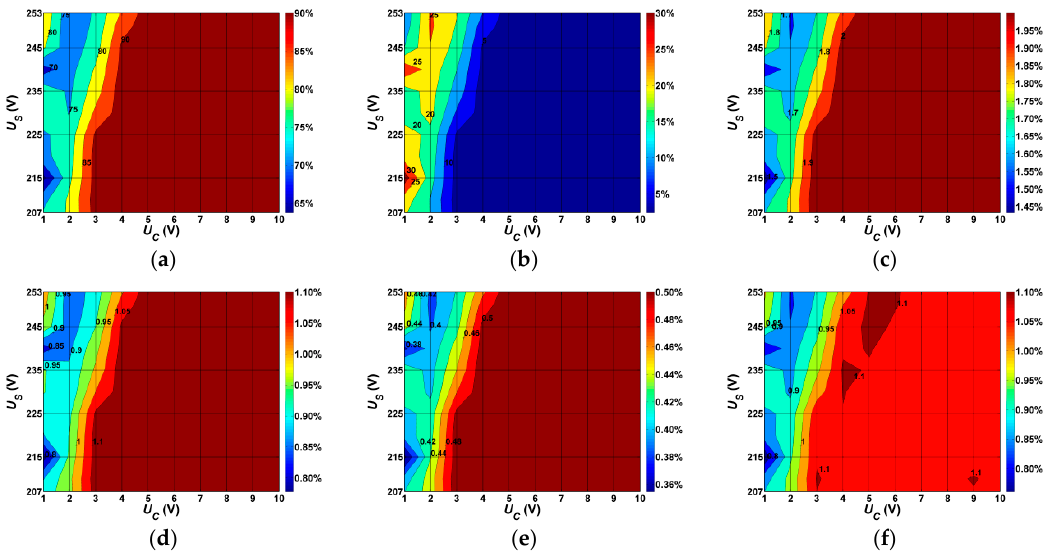
Figure 3. Power losses in elements of the lighting system as percentages of total power losses Δ P TOTAL : ( a ) losses in the supply cable; ( b ) losses in the neutral conductor of the supply cable; ( c ) losses in the wire in the pole between the fuse box and the luminaire; ( d ) losses in the safety device in the distribution board; ( e ) losses in the safety device of the wire in the pole; ( f ) losses in the relay.